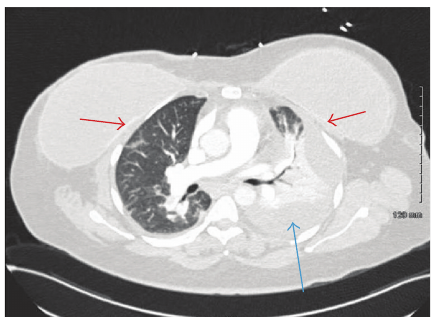
Figure1:ContrastCTofthethoraxshowingmoderatesizeleftsided pleural effusion (blue arrow) and bilateral silicone implants with intact capsule (red arrows).